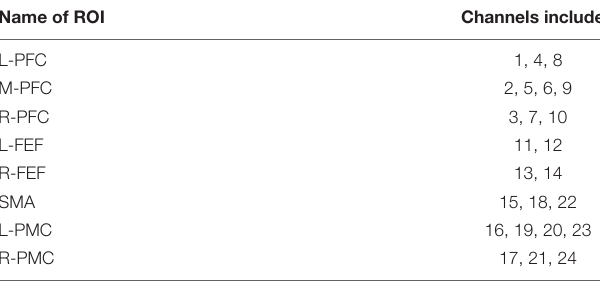
TABLE 1 | The division of region of interest (ROI). Name of